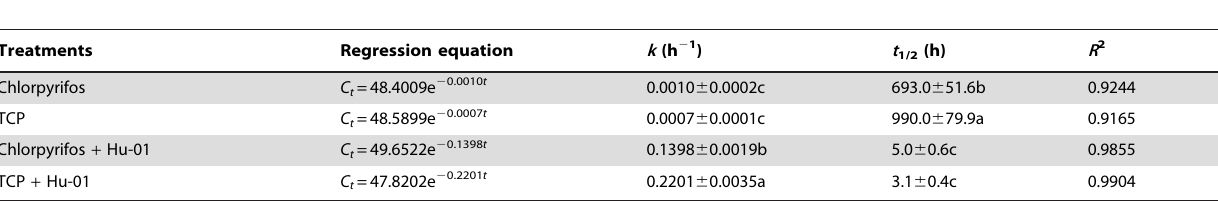
Table 5. Kinetic parameters of degradation of chlorpyrifos and 3,5,6-trichloro-2-pyridinol (TCP) by strain Hu-01.